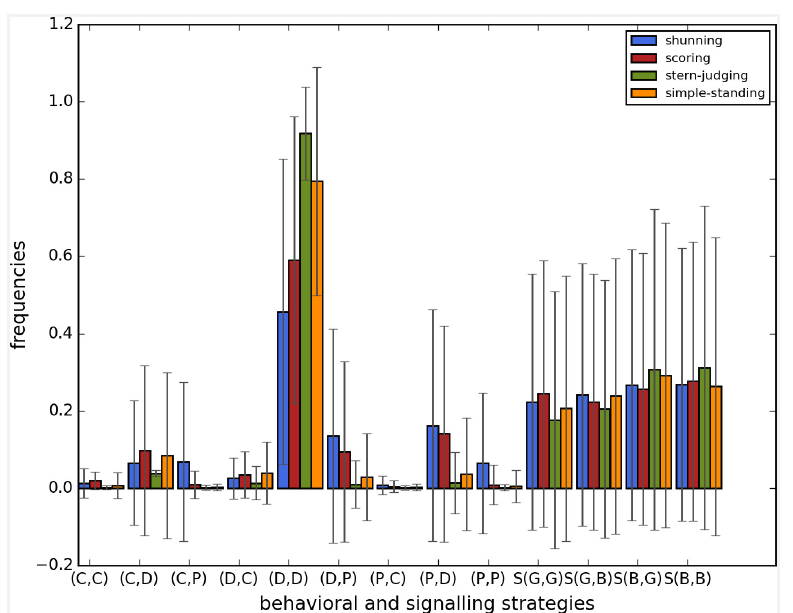
Fig 8. The frequencies of the behavioural and signalling strategies at the end of the simulations, MST90. The figure shows the frequencies of the behavioural and signalling strategies at the end of the simulations. Each bar represents the average of 100 runs, error bars represent standard deviation, parameters are as follows: n = 100, c = 1, α = 1, β = 4, MST = 90%. The x axis shows the behavioral or signalling strategy, the y axis shows the average frequency of that strategy when runs were